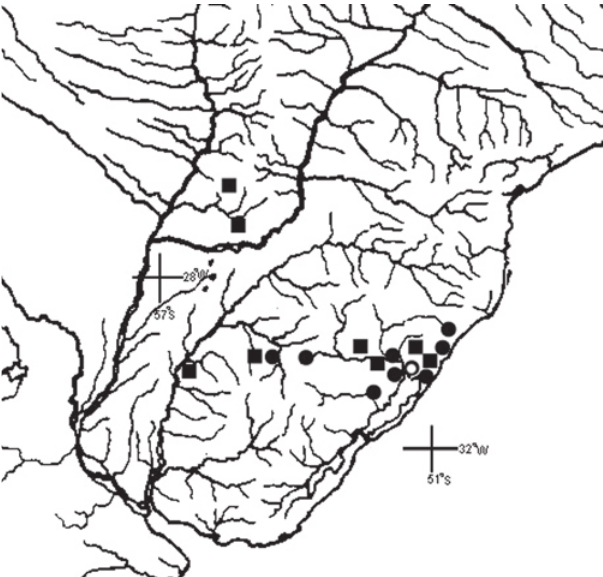
Fig. 5. Map of Southern Brazil, Uruguay, Argentina and Para- guay with the distribution of Brachyhypopomus draco . Squares represent non-type specimens. Empty circle repre- sents the type locality.